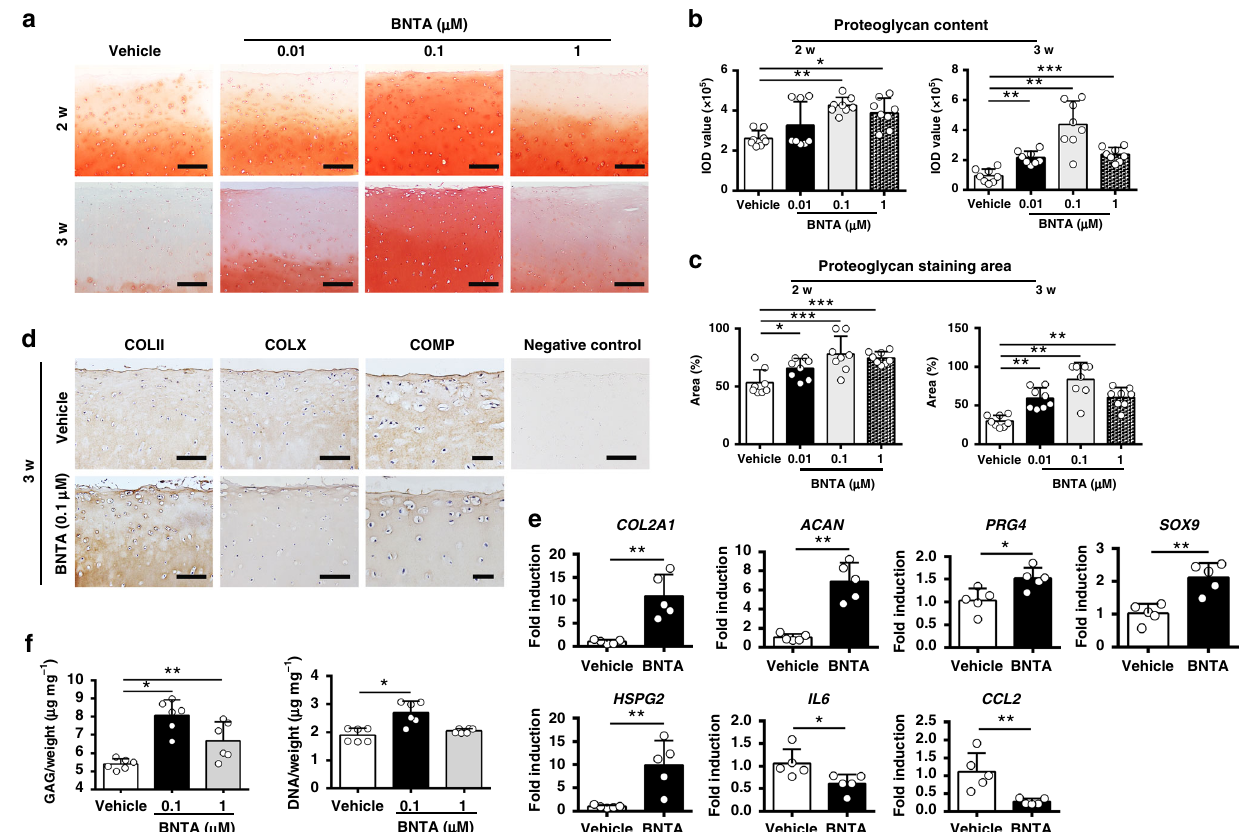
Fig. 2 BNTA enhanced anabolism and inhibited in fl ammatory response in osteoarthritis cartilage explants. a Proteoglycan content was measured by safranin O-fast green staining in OA cartilage explants after 2 and 3 w of incubation with BNTA ( n = 8 for each group; scale bars, 300 μ m). b The integrated optical density value for proteoglycan content determined by safranin O-fast green staining ( n = 8 for each group; one-way ANOVA). c Proteoglycan staining area (%) determined by safranin O-fast green staining ( n = 8 for each group; 2 w, one-way ANOVA; 3 w, nonparametric test). d Immunohistochemistry staining of type II collagen (COLII), type X collagen (COLX), and cartilage oligomeric matrix protein (COMP) in BNTA (0.1 μ M) or vehicle groups ( n = 4; COLII, COLX, scale bars, 150 μ m; COMP, scale bars, 50 μ m). e The mRNA levels of anabolic and in fl ammatory biomarkers in OA cartilage explants analyzed by reverse transcription polymerase chain reaction (RT-PCR) after BNTA treatment (0.1 μ M) for 3 w ( n = 5 for each group). proteoglycan 4 ( PRG4 ), SRY-box 9 ( SOX9 ), and interleukin 6 ( IL6 ), unpaired two-tailed Student ’ s t -test; collagen type II alpha 1 chain ( COL2A1 ), aggrecan ( ACAN ), heparan sulfate proteoglycan 2 ( HSPG2 ), and C-C motif chemokine ligand 2 ( CCL2 ), nonparametric test. f glycosaminoglycan (GAG) and DNA content per wet weight was assessed by 1, 9-dimethylmethylene blue (DMMB) and Hoechst 33258 assays after vehicle or BNTA treatment for 2 w, separately ( n = 6 for each group; nonparametric test). Data are shown as the mean ± standard deviation (s. d.). * P < 0.05, ** P < 0.01, *** P < 0.001. Source data are provided as a Source Data fi